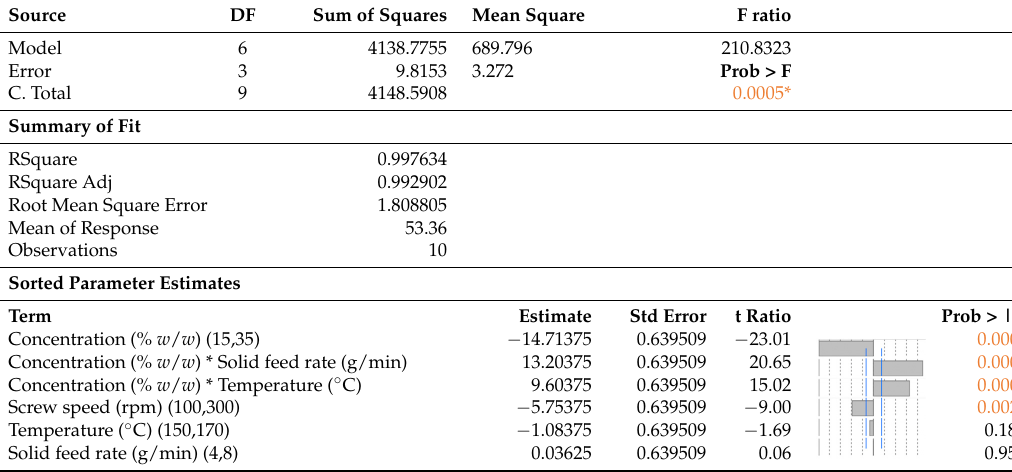
Table 2. Analysis of variance for response L* (DoE1).